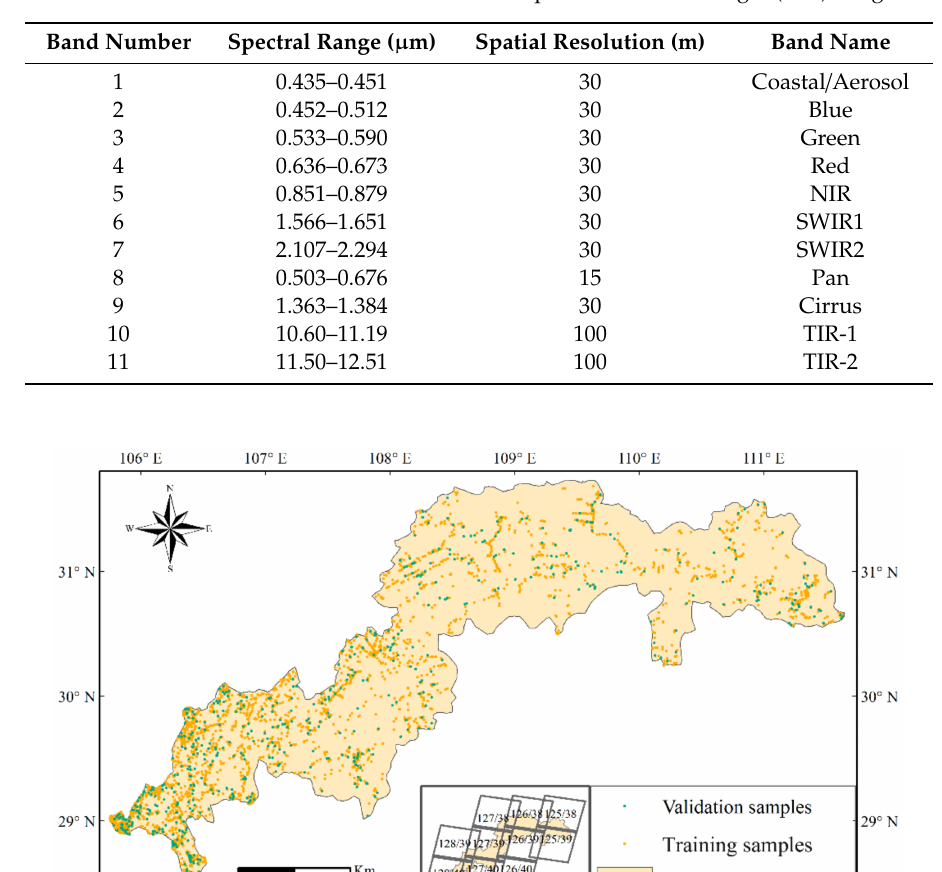
Table 2. Detailed information on the Landsat 8 Operational Land Imager (OLI) images.